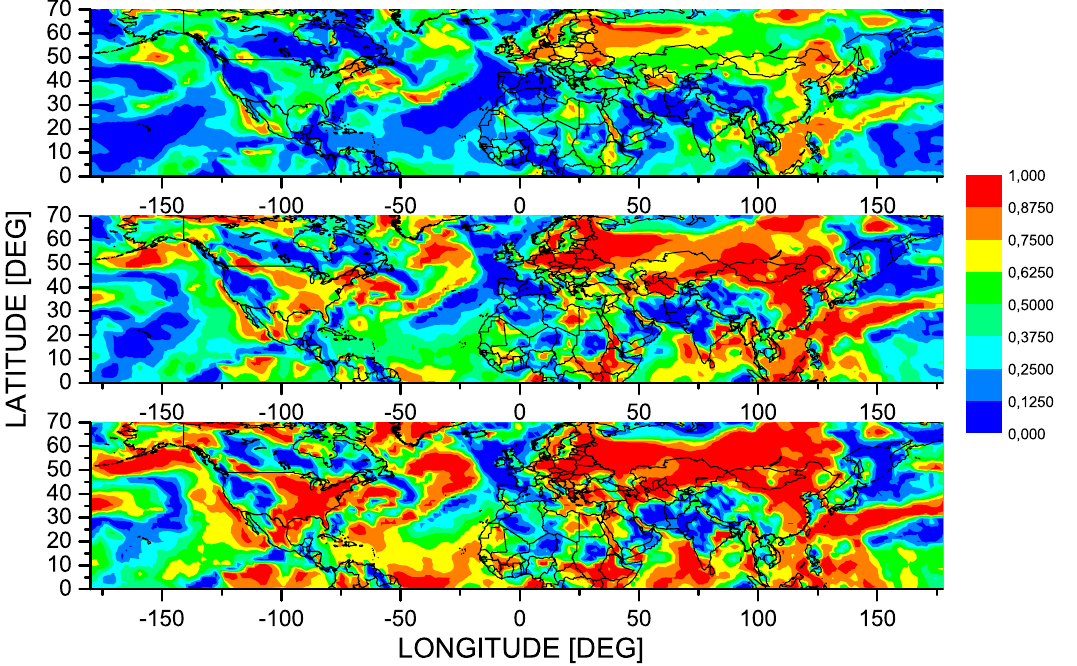
Fig. 3. The mean phase coherence between the sunspot data (top panel), geomagnetic aa index (middle panel), NAO index (bottom panel) and the NCEP/NCAR near-surface air temperature for the oscillatory modes obtained using CCWT with the central wavelet period 96 months.